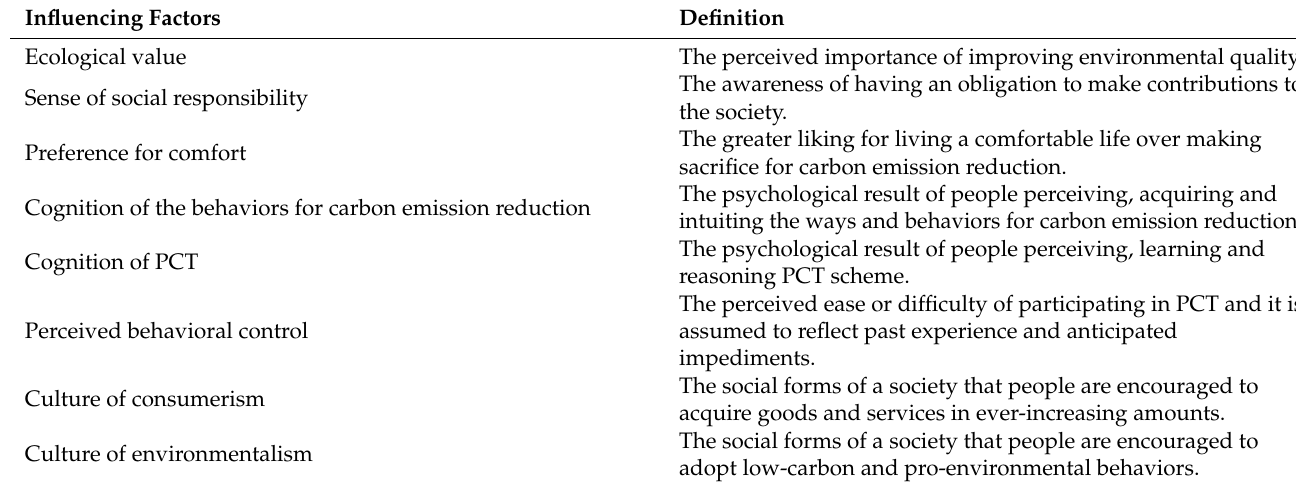
Table 1. Definitions of the influencing